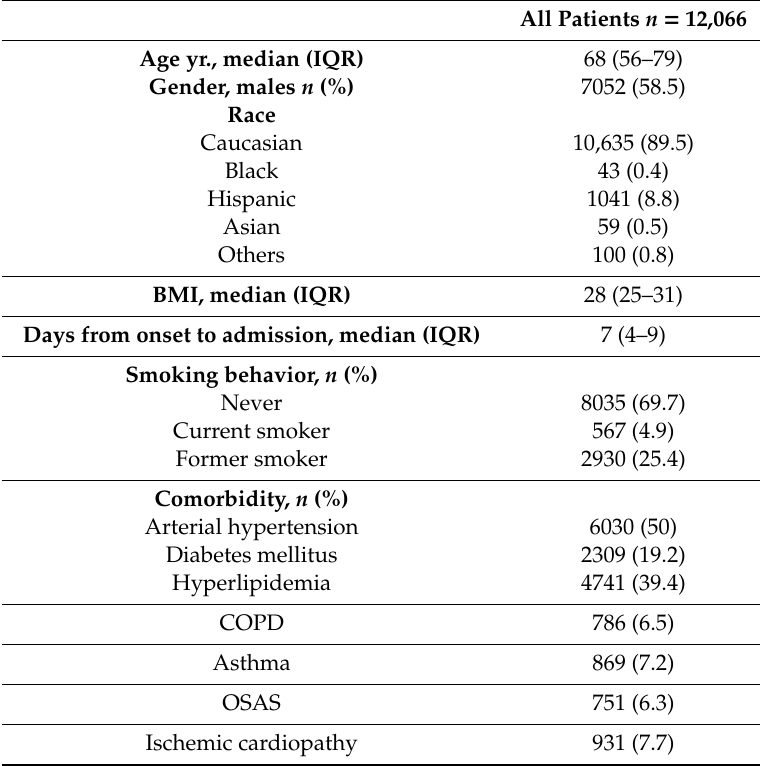
Table 1. General data of all